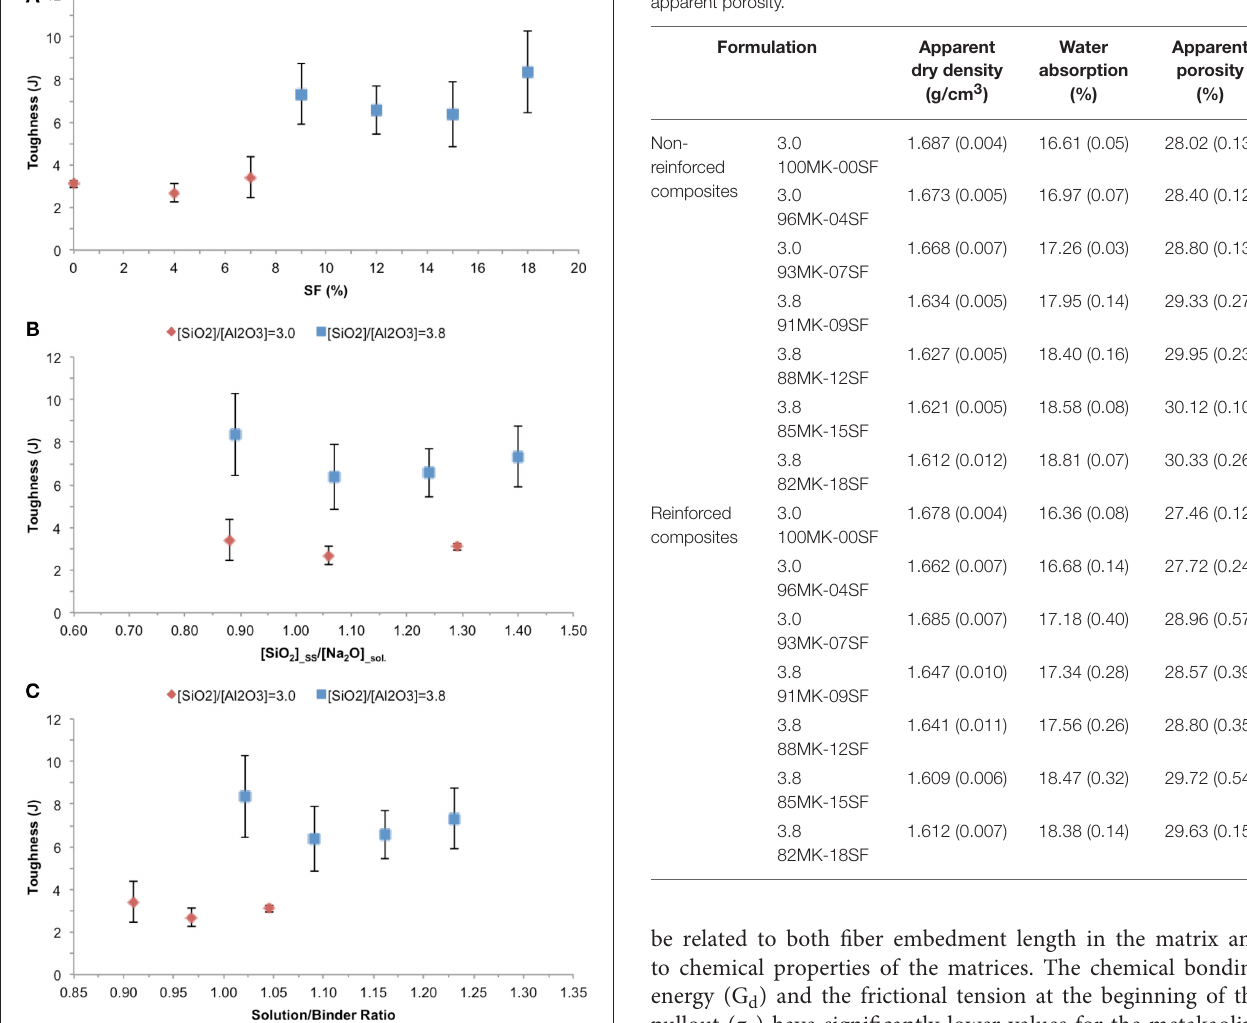
TABLE 2 | Mortars apparent specific dry density, water absorption, and apparent